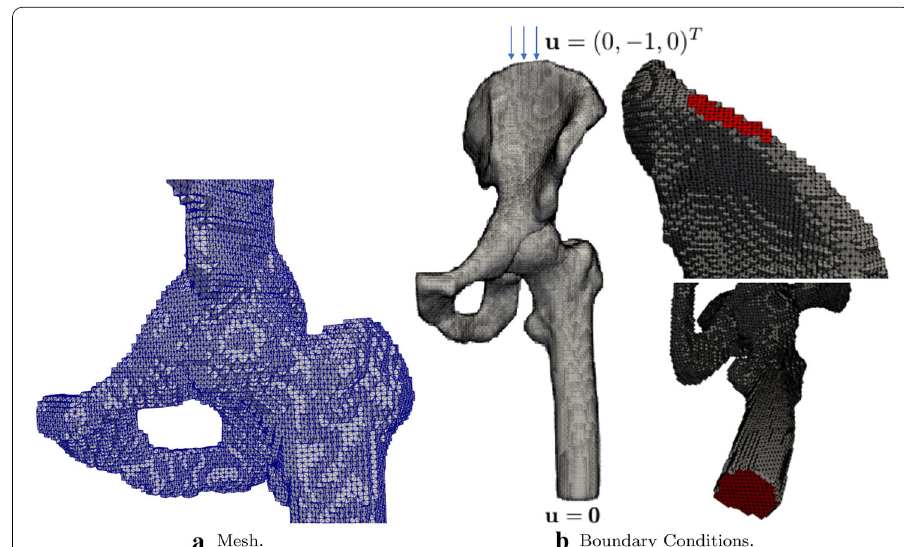
Fig. 10 Mesh and boundary conditions